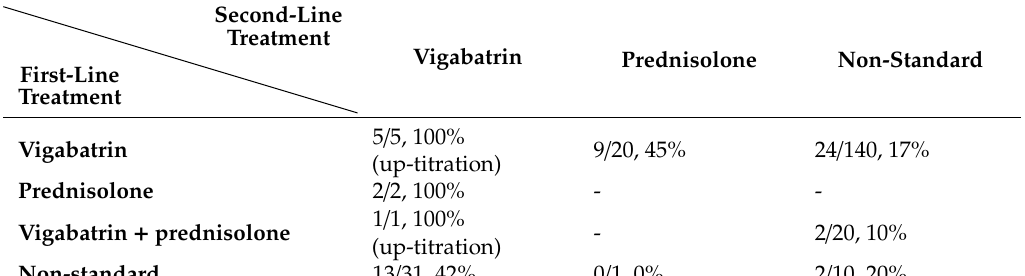
Table 4. Response rate to second-line treatment.